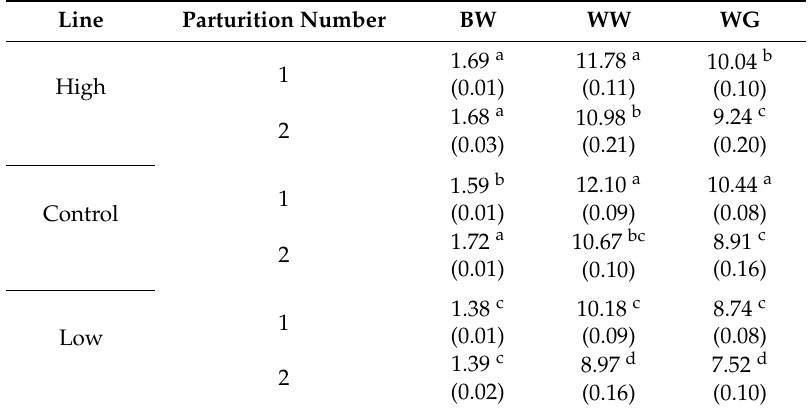
Table 4. Mean and standard deviation (in brackets) for birth weight, weaning weight, and weight gain during lactation for line and parturition number.